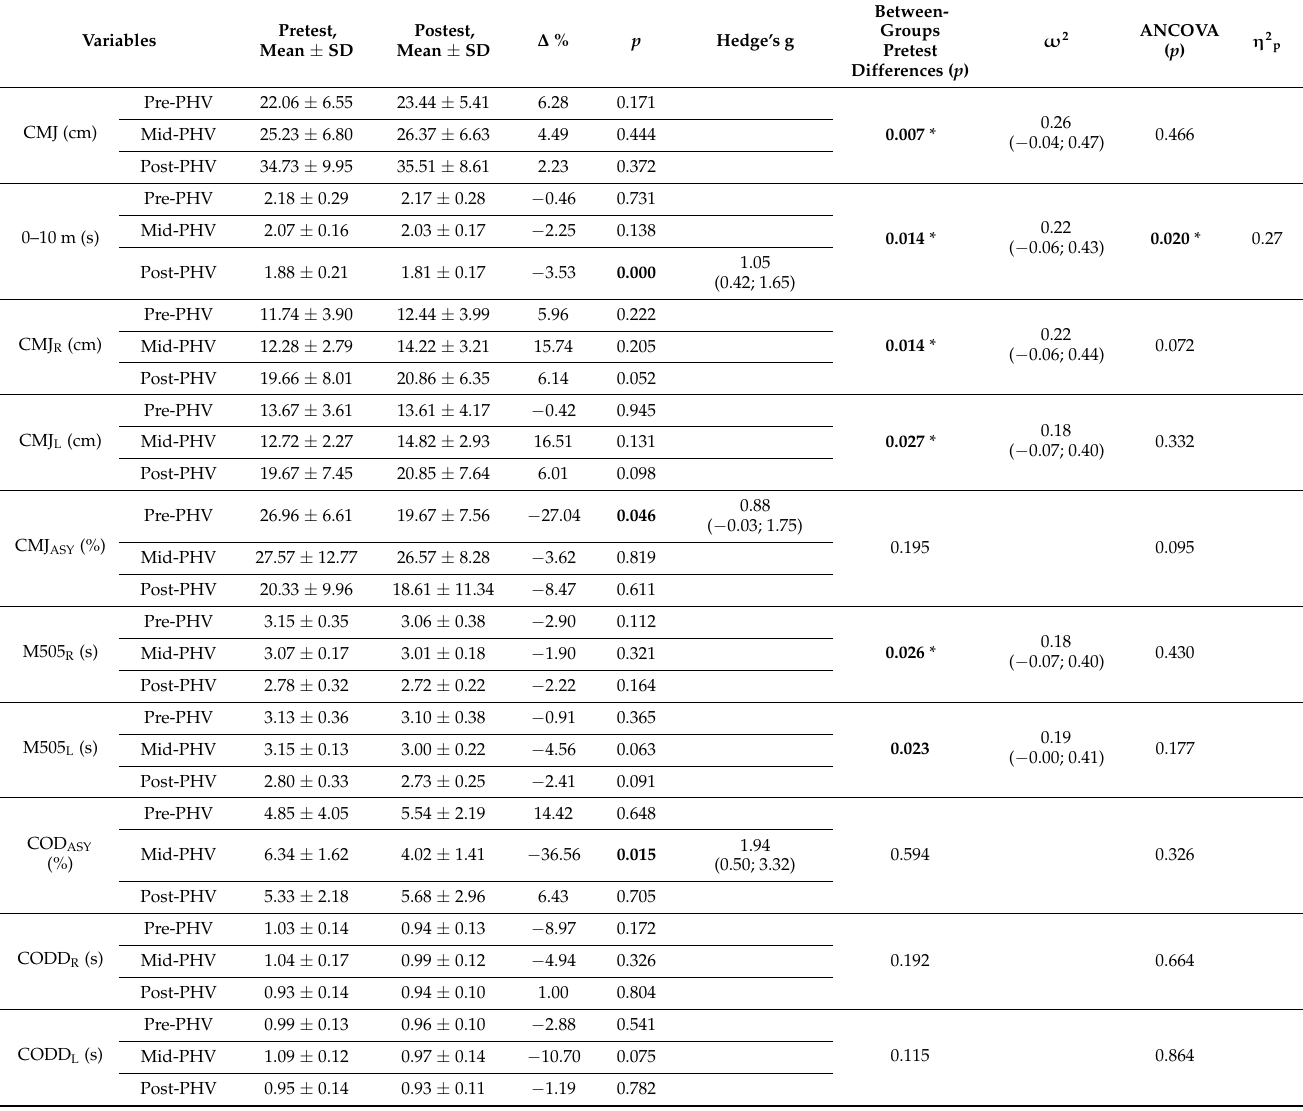
Table 3. Inferences of the training programs intervention on subject’s performance